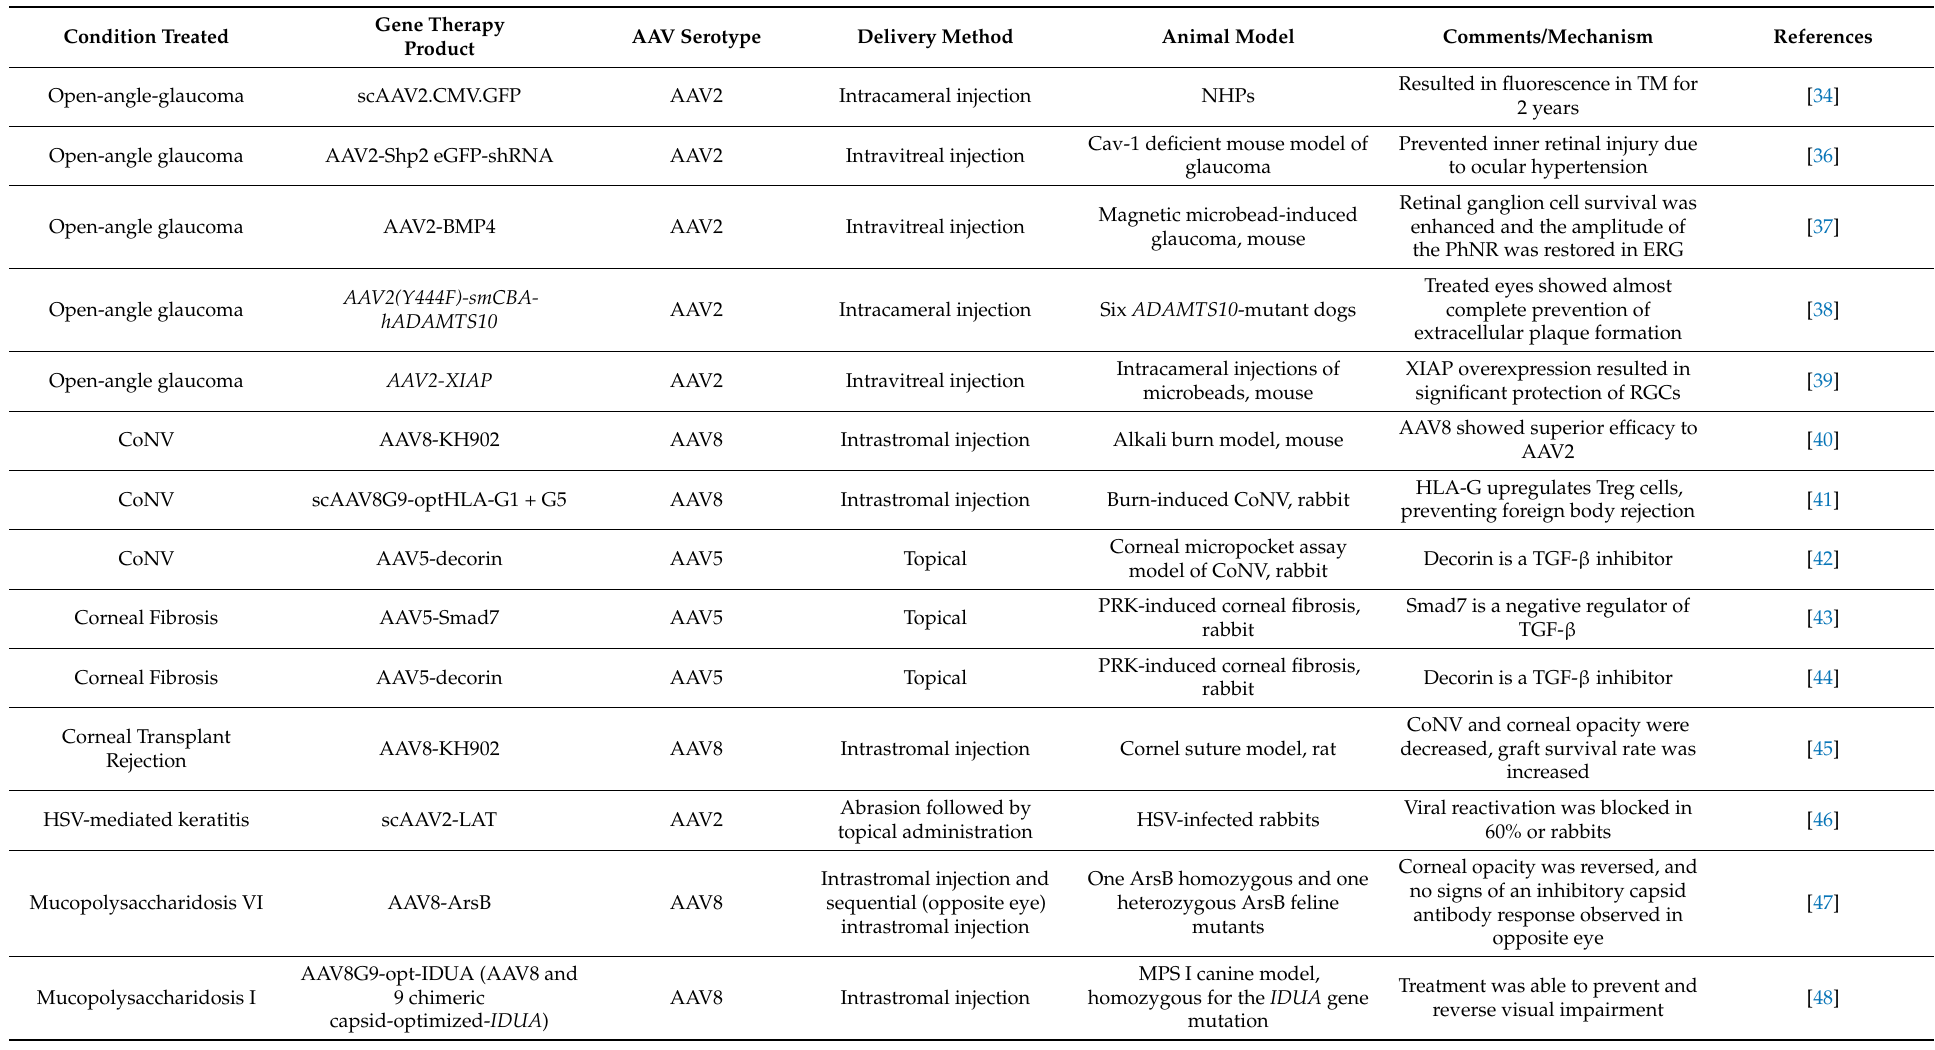
Table 2. Pre-clinical trial gene therapy products for the treatment of glaucoma and corneal